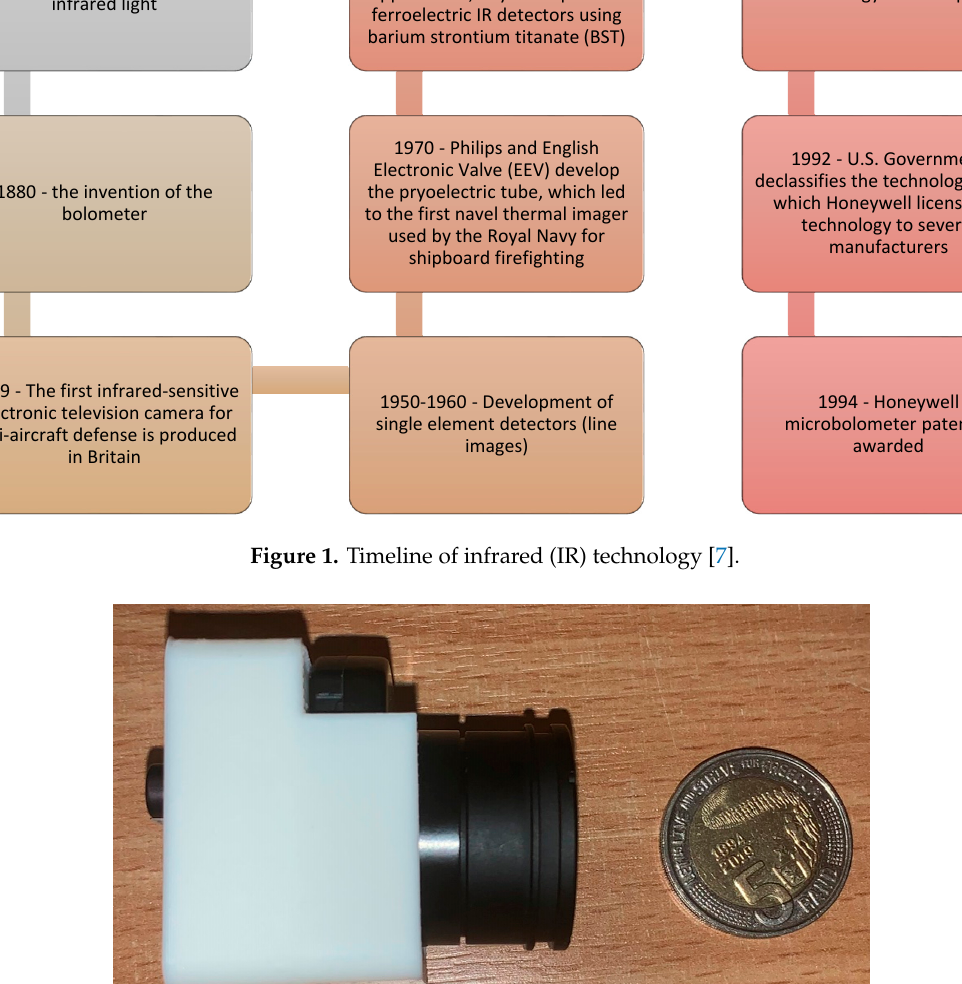
Figure 1. Timeline of infrared (IR) technology [7] .